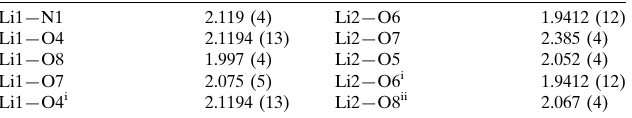
Selected bond lengths (A˚ ).